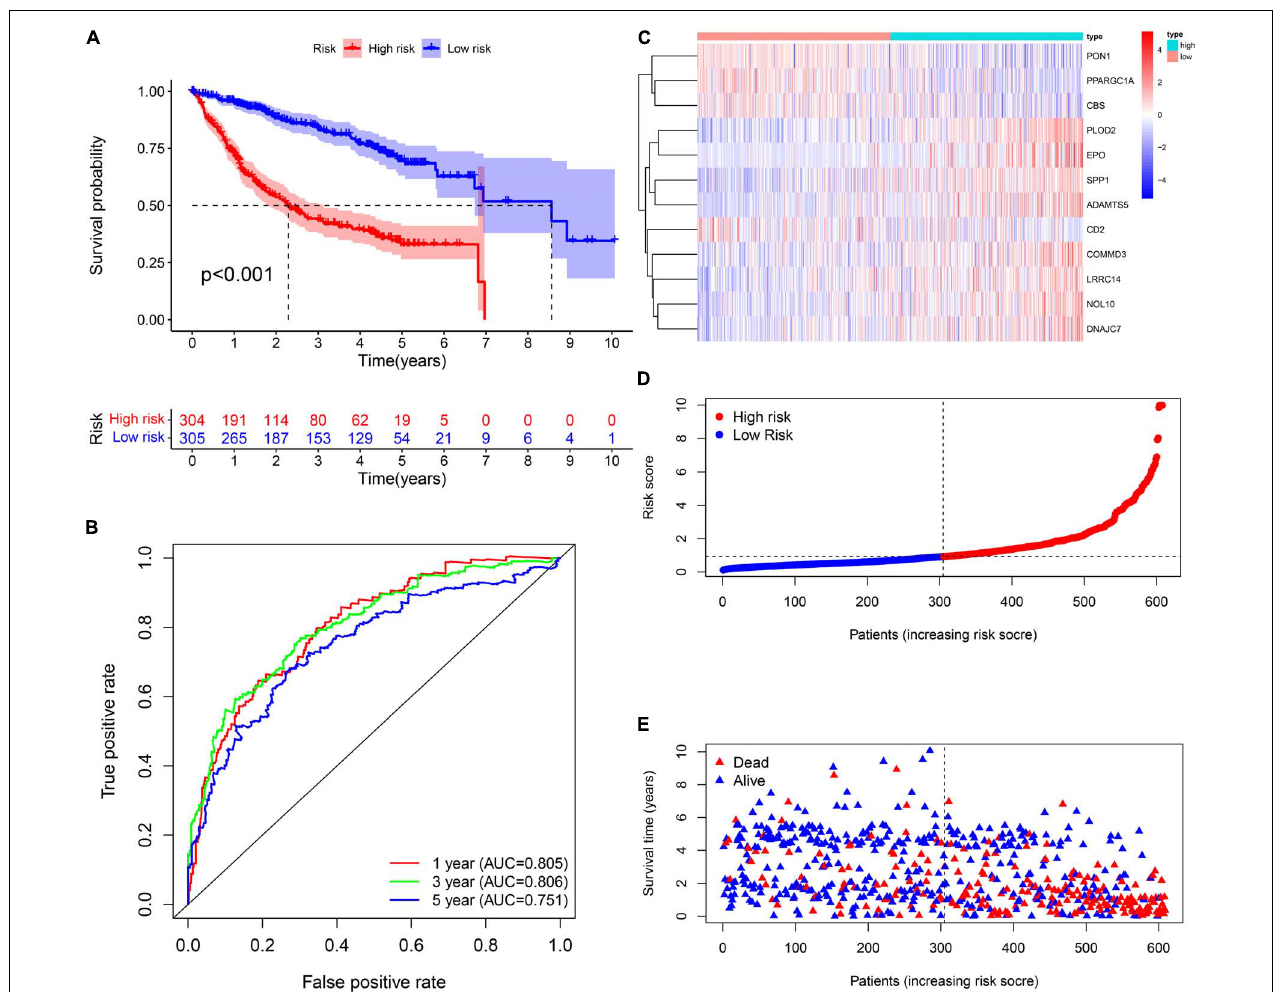
FIGURE 3 | Prognostic assessment of the prognostic signature in the training cohort. (A,B) The Kaplan–Meier survival analysis and the time-dependent ROC analysis for the risk score in predicting the OS of patients in the training cohort. (C–E) The heatmap, risk score distribution, and survival status of patients in the training